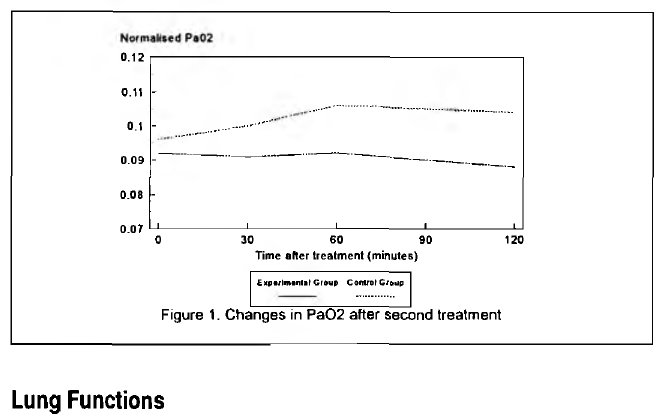
Figure 1. Changes in Pa02 after second treatment